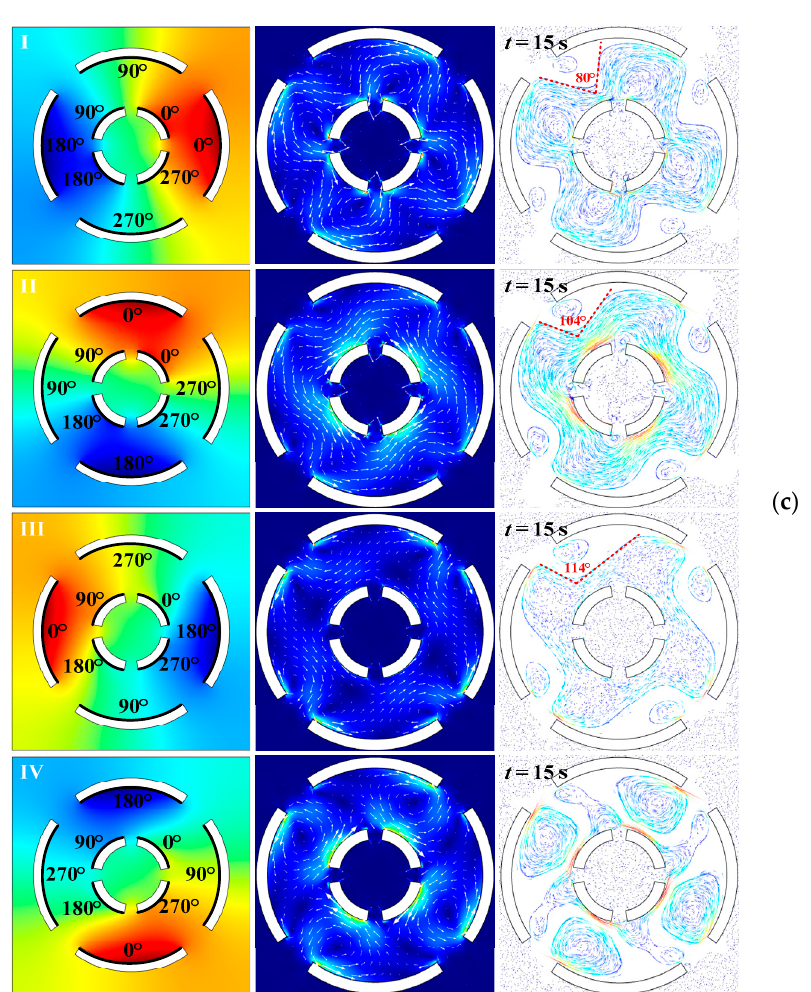
Figure 5. (Color online). Acoustofluidic field and particle trajectory excited by double-layer vibration sources with different initial phases. ( a ) Computational model. ( b ) Simulation results with the same initial phase of the identical layer. ( c ) Simulation results with different initial phases of the identical layer.